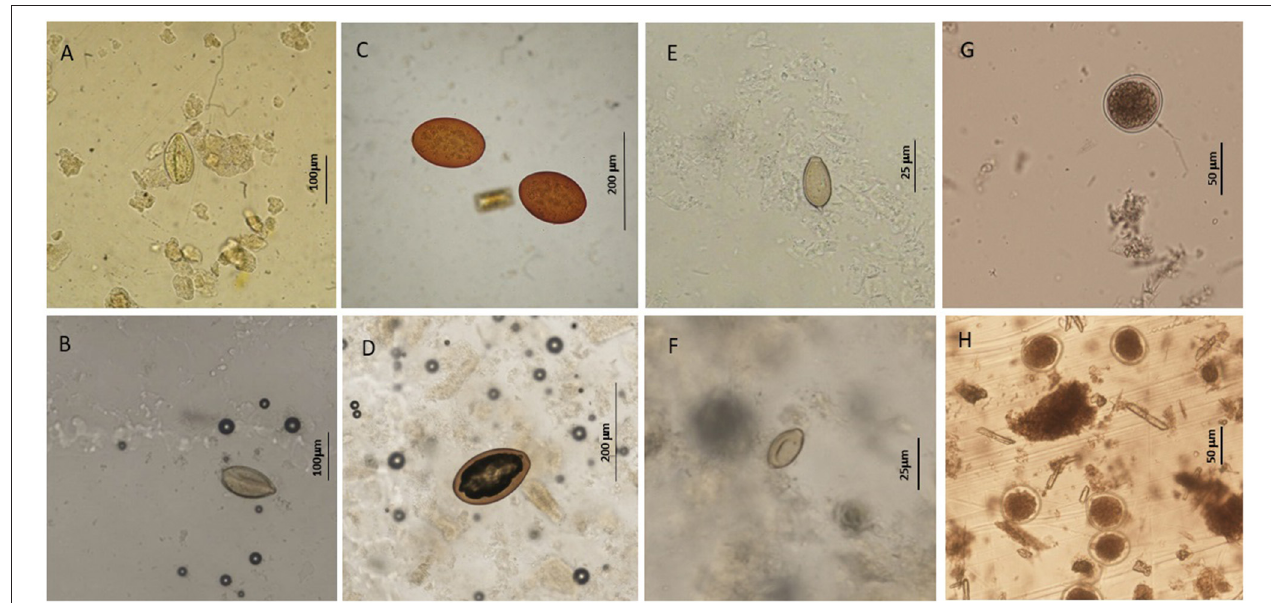
FIGURE 1 | Helminth parasites’ eggs detected in this study by sedimentation and flotation method (A,C,E,G) and Mini-FLOTAC technique (B,D,F,H) using fresh and preserved samples respectively. (A,B) eggs of Synthesium tursionis and (C,D) eggs of Braunina cordiformis from Tursiops truncatus ; (E,F) eggs of Pholeter gastrophilus from Stenella coeruleoalba ; (G,H) eggs of Anisakis sp. from Stenella coeruleoalba .